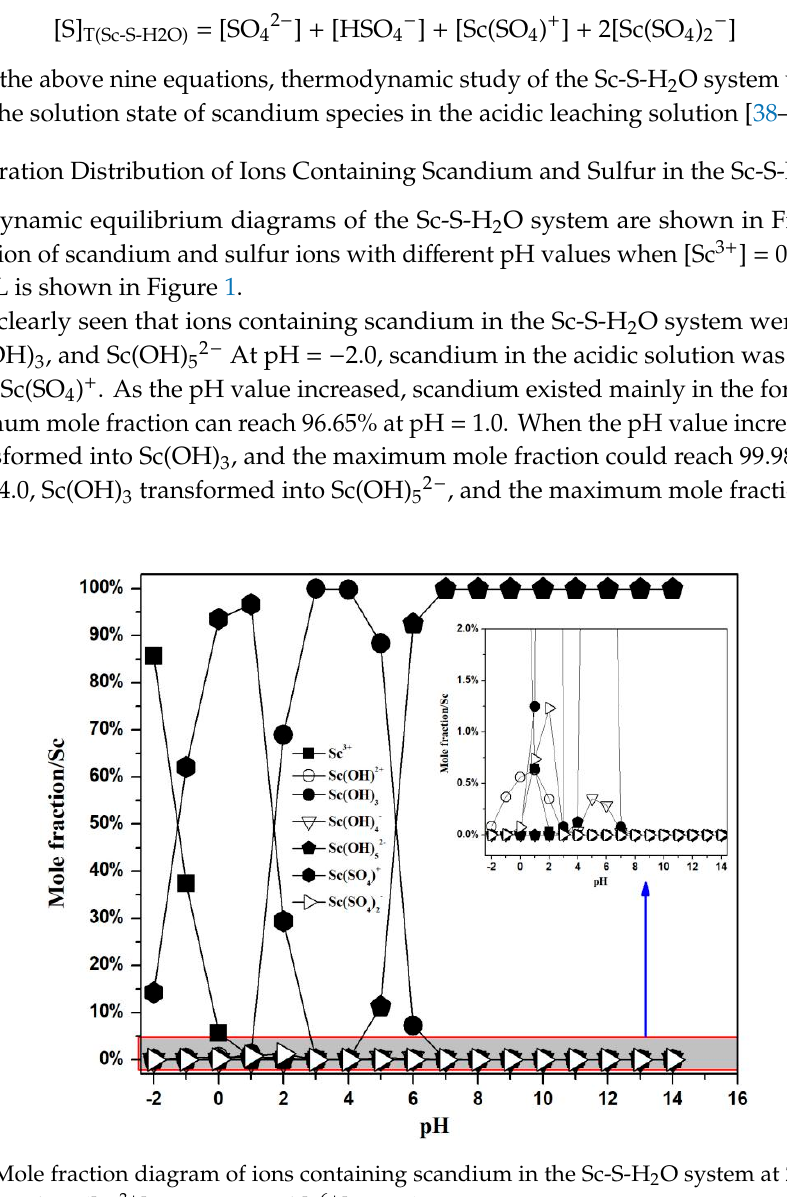
Figure 2. Mole fraction diagram of ions containing sulfur in the Sc-S-H 2 O system at 298 K with various pH values ([Sc 3+ ] = 0.001 M and [S 6+ ] = 4 M). 3.2. Solvent Extraction of Sc(III) by Using D2EHPA and TBP 3.2.1. Effect of Extractant D2EHPA Concentration on the Sc Extraction